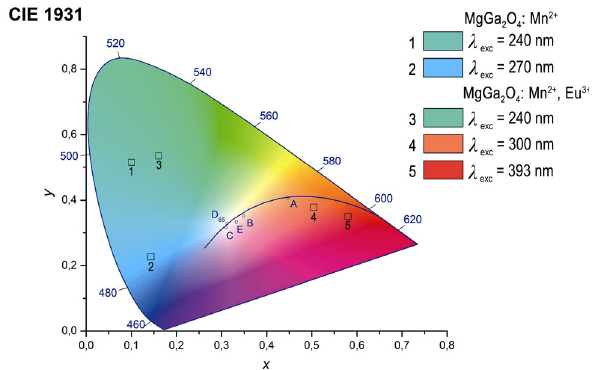
Fig. 11 CIE chromaticity diagram of the MgGa 2 O 4 :Mn 2+ and MgGa 2 O 4 :Mn 2+ ,Eu 3+ ceramics with emission color samples at different excitations with respect to black body curve and A–E standard illuminants.